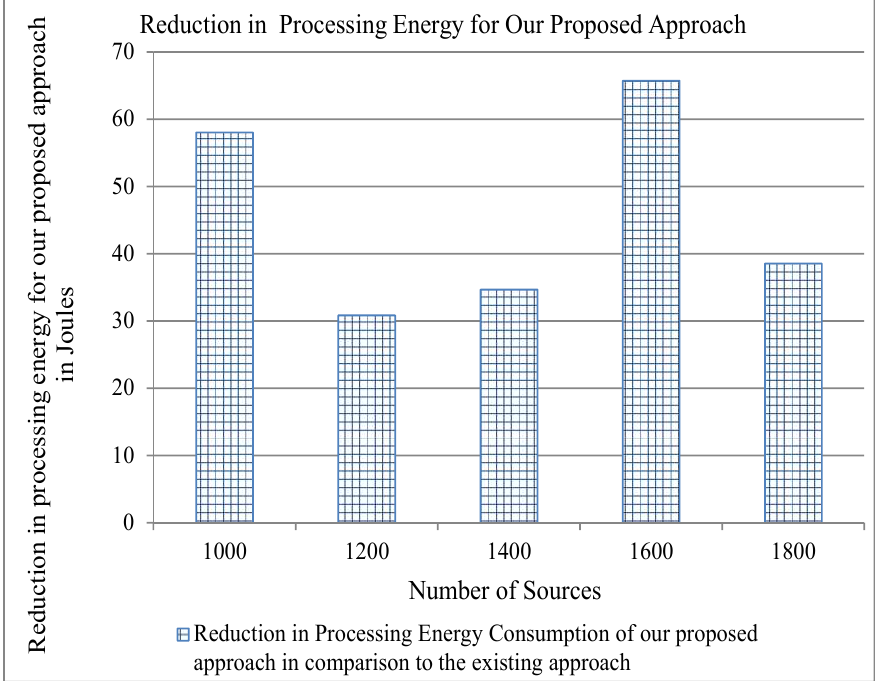
Figure 12. Reduction in Processing Energy for our proposed approach in comparison to the existing for three cache